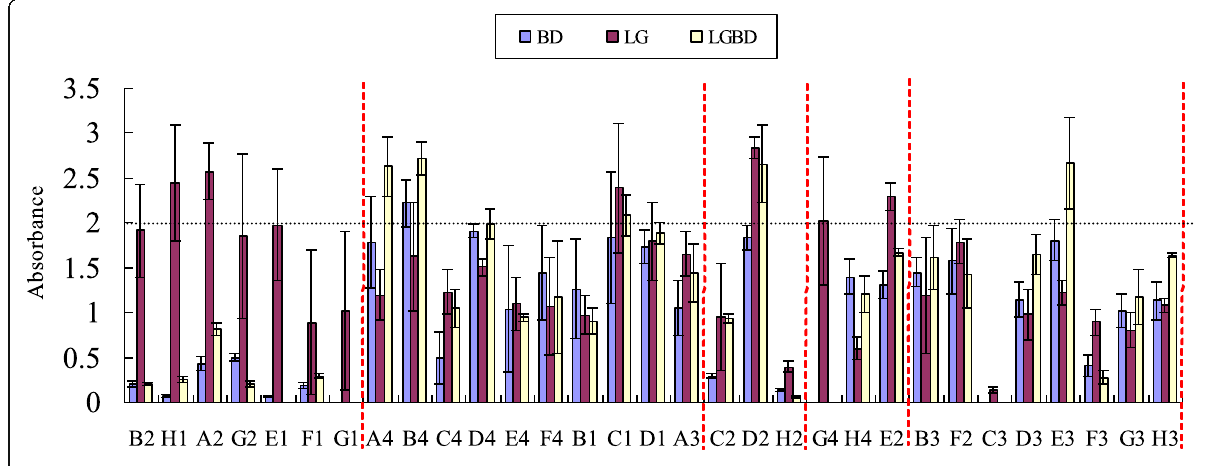
Fig. 2 Metabolic fingerprint of carbon physiological profiles of the microbial community. Note: LG, Larix gmelinii ; BD, Betula dahurica ; LGBD, mixed Larix gmelinii and Betula dahurica . B2, H1, A2, G2, E1, F1 and G1: carbohydrates; A4, B4, C4, D4, E4 and F4: amino acids; B1, C1, D1 and A3: esters; C2, D2 and H2: alcohols; G4, H4 and E2: amines; B3, F2, C3, D3, E3, F3, G3 and H3: